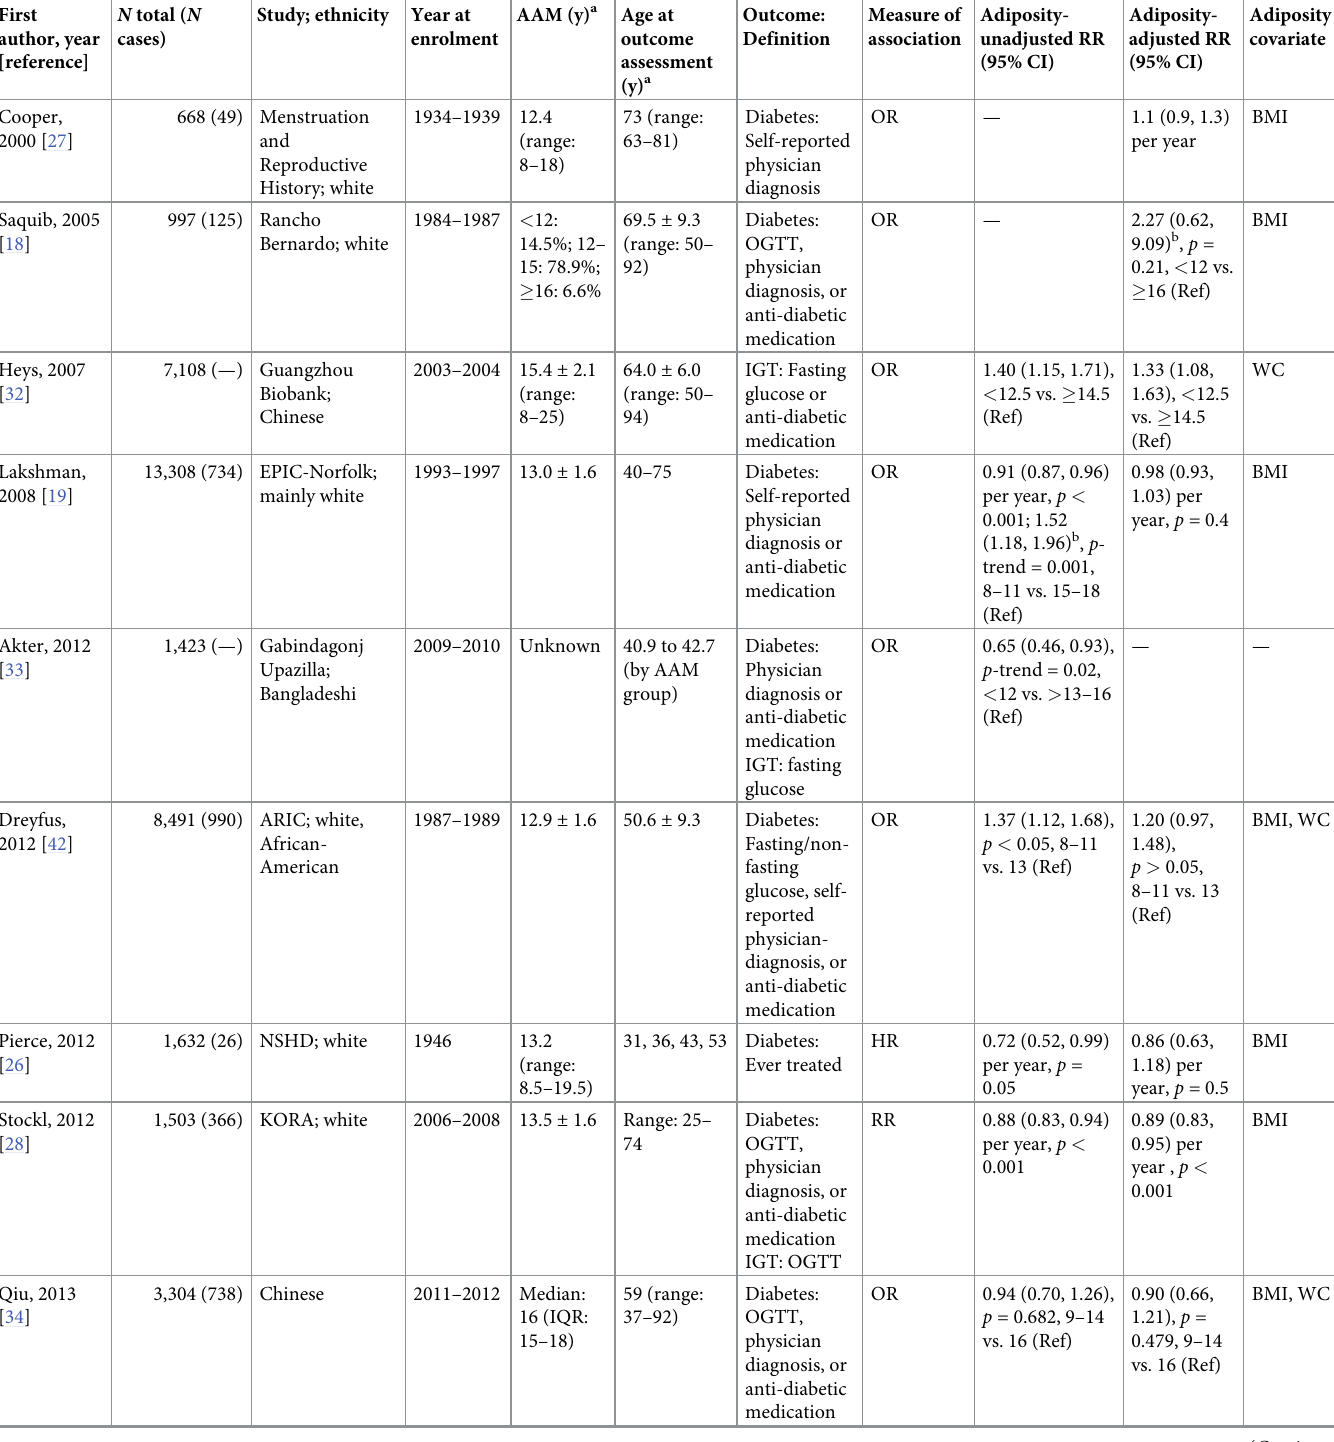
Table 1. Summary of eligible studies of prevalent